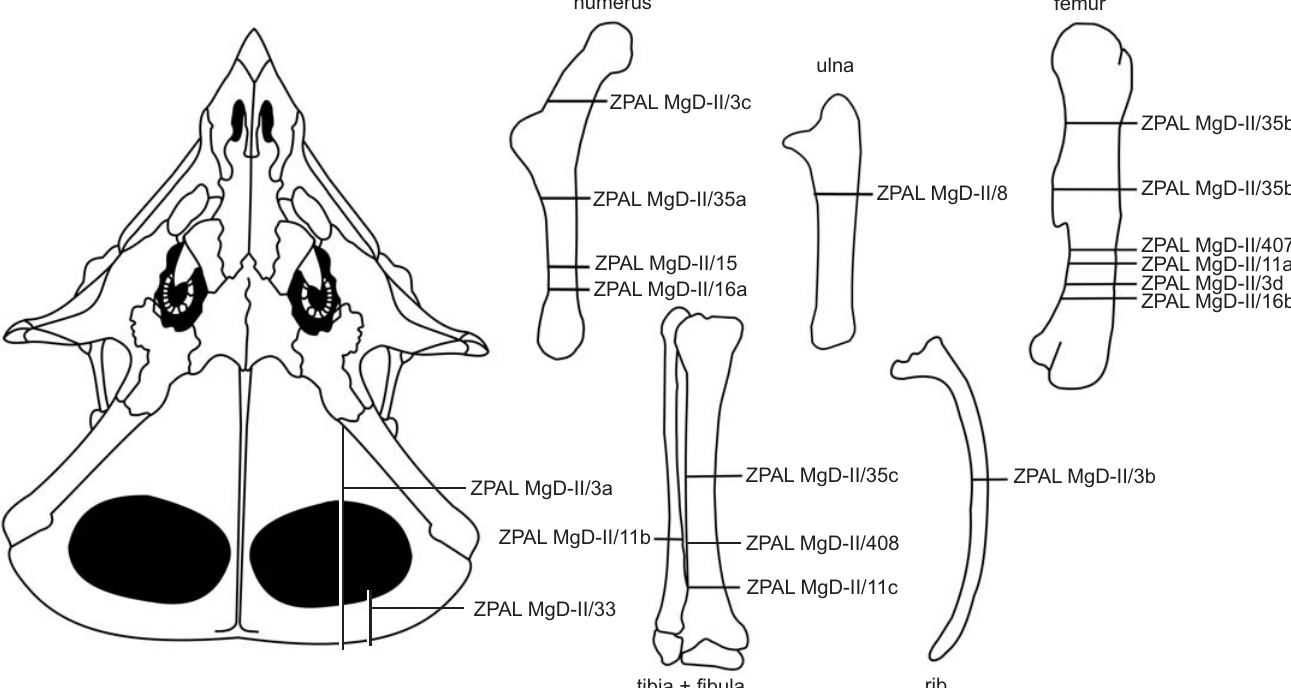
Fig. 1. Schematic drawing of the studied bones of Protoceratops andrewsi Granger and Gregory, 1923 showing the thin-section locations. Catalog num- bers designate the studied